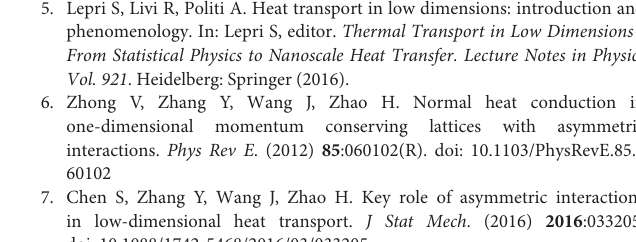
FIGURE 7 | Normalized energy flux J n (o) and the flux J ( Equation (11) for chains of different lengths ( N with T L 1 and T R 10. Although J n is not exactly constant, at large N it = = enjoys small fluctuations about a given average